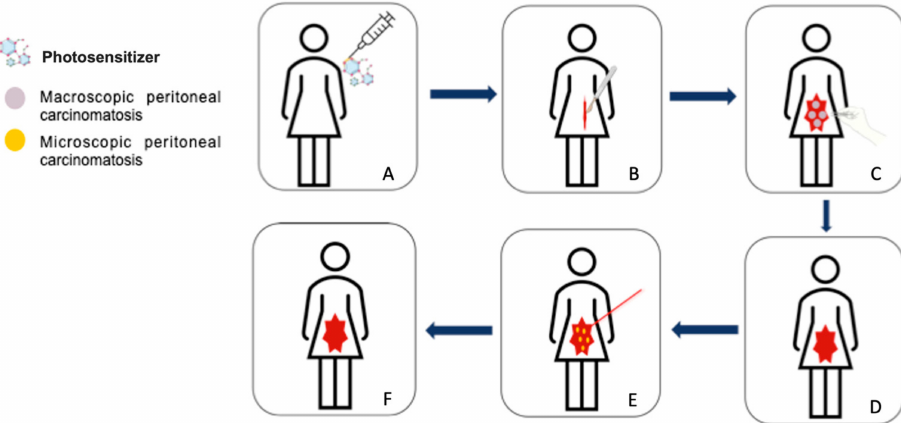
Figure 2. Intraperitoneal photodynamic therapy protocol for peritoneal metastases of advanced ovarian cancer. ( A ) Administration of the photosensitizer, ( B ) open approach (laparotomy) to perform macroscopic complete cytoreductive surgery, ( C ) cytoreductive surgery (hysterectomy, bilateral adnexectomy, omentectomy, appendectomy +/- pelvic and para-aortic lymphadenectomies, removal of all visible peritoneal metastases), ( D ) end of the cytoreductive surgery, ( E ) illumination of the peritoneal cavity to treat by photodynamic therapy microscopic peritoneal metastases, ( F ) end of the